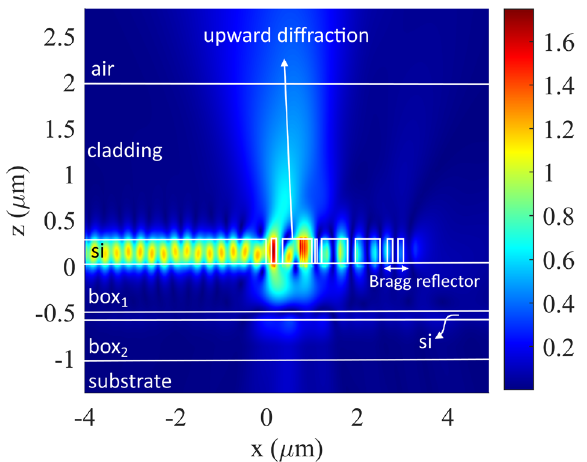
Figure 4. 3D FDTD simulation of the amplitude of the scattered electric field on the x–z cross-section positioned at the center of the transversally-interleaved chirped antenna.